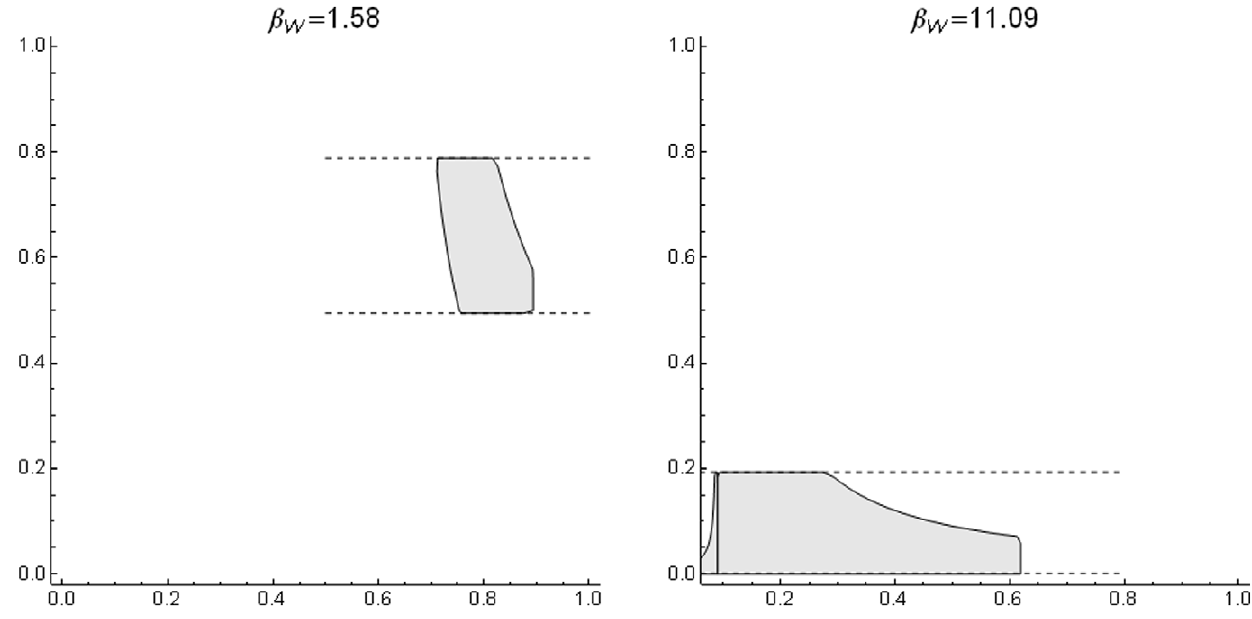
Figure 1. Mathematical constraints of data points plotted in a proportional richness ( a (cid:2) The graph in the left is a relatively low beta-diversity subregion of the world (the Smoky Mountains); the graph in the right is a high beta diversity region (the entire Indo-Malay region). Both regions have cells of a resolution of 10,000 km 2 but differing in extent (216 cells the Smokey Mountains and 951 cells the Indo-Malay region). For each one, the grey area represents the region where data points can occur, as implied by equation (2). The curved lines are the maximum and minimum isocovariance lines respectively, plotted using equation (2). The dashed lines are the maximum and . minimum observed a (cid:2) i